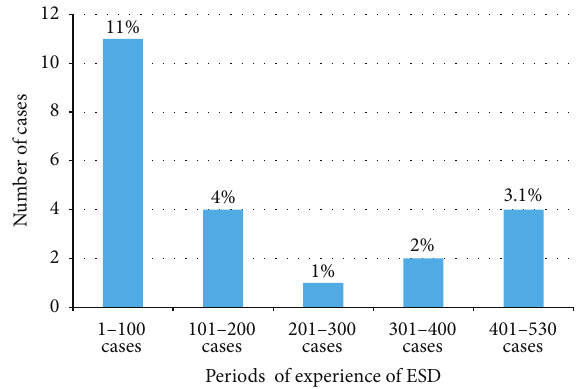
Figure 3: Rate of perioperative perforation in every 100 cases of colorectal endoscopic submucosal dissection